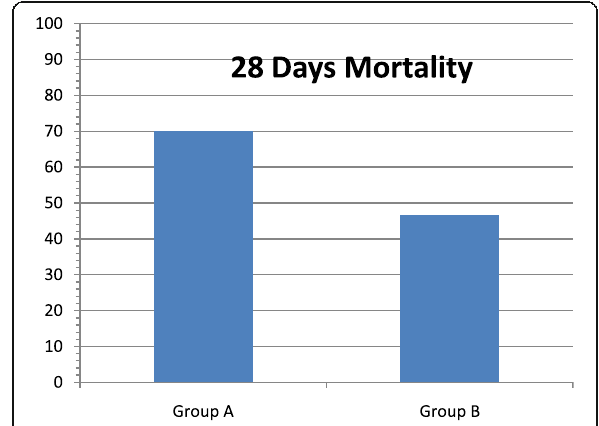
Fig. 8 Bar chart showing the comparison between group A (control) and group B (esmolol) according to 28-day mortality (percentage)